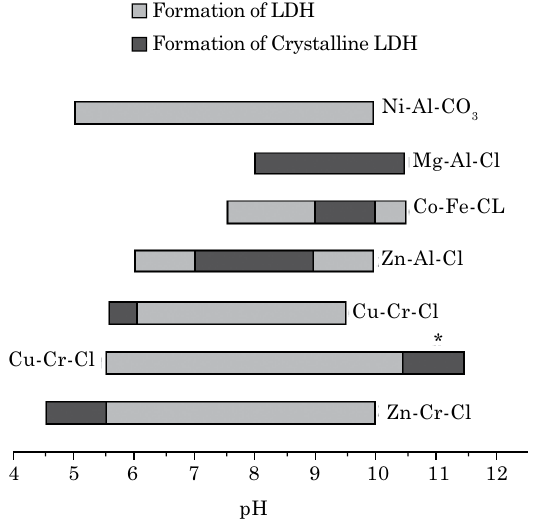
Figure 2. pH domains and optimal ranges for the formation of some LDH. * Hydrothermal treatment. Adapted from De Roy et al.